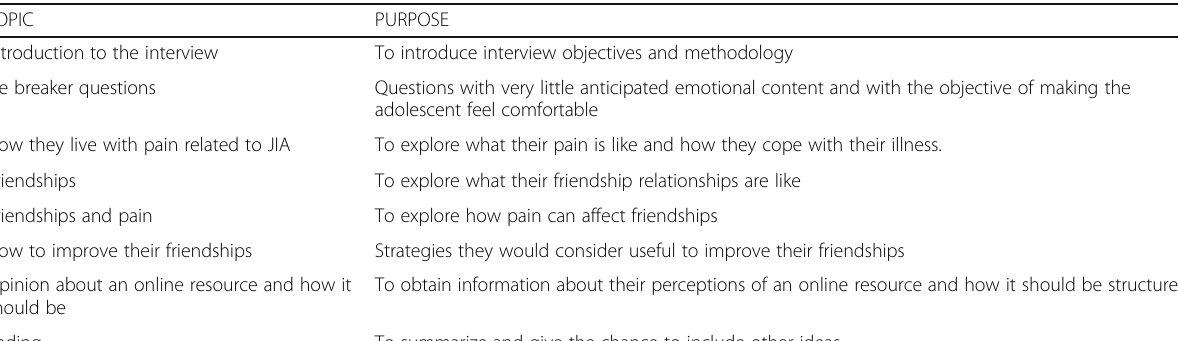
Table 1 Agenda for the semi-structured